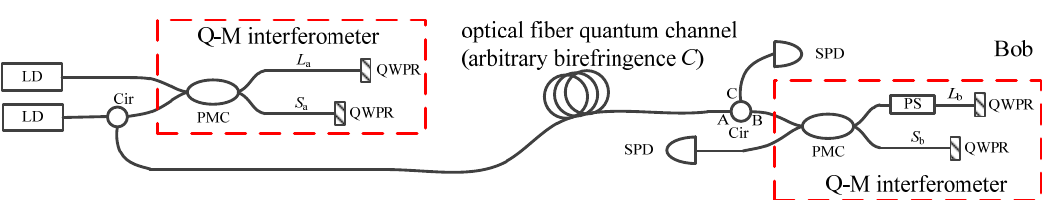
Figure 3. Double Q–M interferometers on Alice’s and Bob’s side, respectively, connected with each other by optical fiber quantum channel. LD: laser, Cir: optical circulator, PMC: polarization maintaining coupler, PS: phase shifter, QWPR: quarter-wave plate reflector, SPD: avalanche diode single photon detector, L i ( i = a or b ): the long arm operator of the Q–M interferometer on Alice’s or Bob’s side, S i ( i = a or b ): the short arm operator of the Q–M interferometer on Alice’s or Bob’s side.